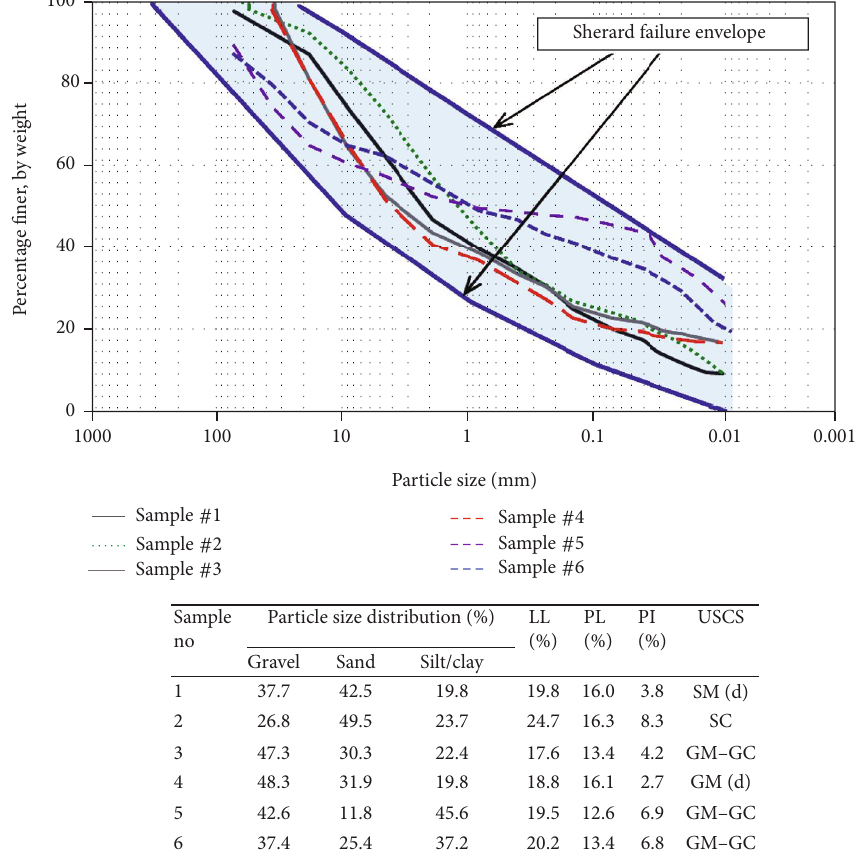
Figure 18: Grain size distribution curves, Atterberg limits, and the USCS classi fi cation of matrix samples from Karli